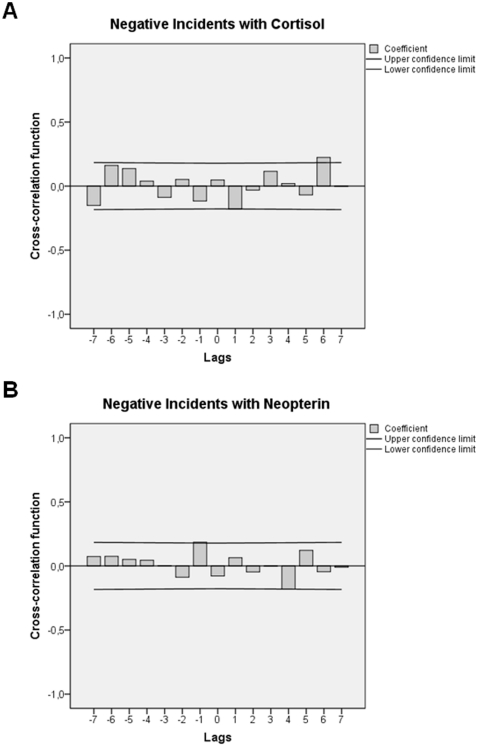
Adjusted cross-correlation functions indicating that negative (“somewhat, moderately, and marked stressful”) incidents are associated with cyclic responses in urinary cortisol and urinary neopterin levels.Each lag represents a time interval of 12 h. Coefficients (bars) reaching the upper or lower confidence limits (lines) are significant at p<.05. In A) negative incidents are followed by urinary cortisol concentration decreases at +lag 1 (12–24 h) and increases at +lag 6 (72–84 h). In B) negative incidents are preceded by urinary neopterin level increases at −lag 1 (0–12 h) and followed by urinary neopterin level decreases at +lag 4 (48–60 h).